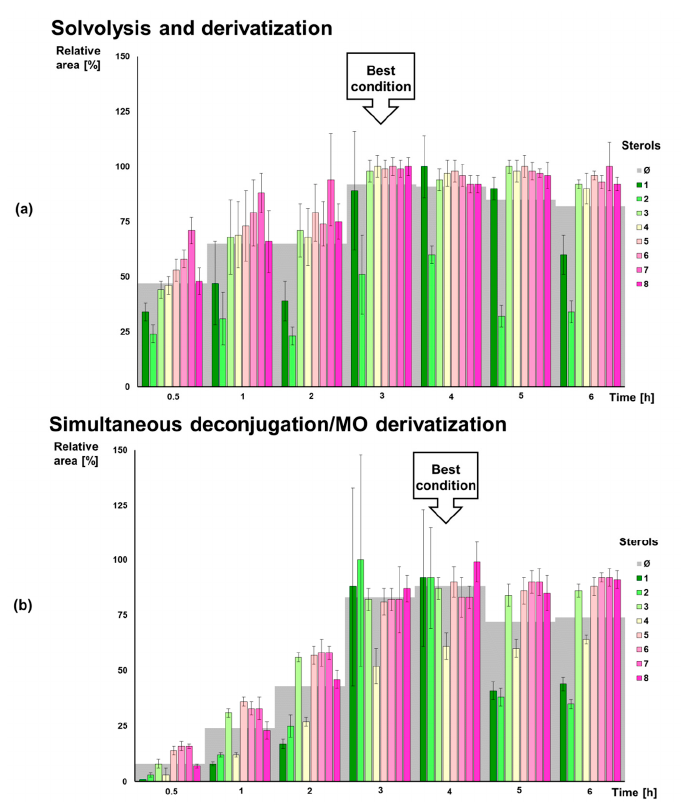
Figure 6. Determination of (keto-)sterol sulfates 1–8 as (MO-)TMS derivatives ( a ) with and ( b ) without previous sulfate solvolysis step (with 1% acetic acid in 1,4-dioxane). The indicated time refers to the duration of solvolysis prior to MO-TMS derivatization (for ”Solvolysis and derivatization”, ( a )) or to the incubation with O -methylhydroxylamine solution (for ”Simultaneous deconjugation / MO derivatization”, ( b )). The results obtained for each individual sterol sulfate under the di ff erent conditions are shown as relative peak areas [%] ± standard deviation (n = 6); the mean value of all steroids for every time point is shown in the background (grey), the best conditions for all tested sterol sulfates are marked as “Best condition”. The maximum recorded peak area for each sterol derivative within this experiment was set as 100%. Analyzed sterols: 1 androsterone sulfate, 2 dehydroepiandrosterone sulfate, 3 epiandrosterone sulfate, 4 allopregnanolone sulfate, 5 pregnanolone sulfate, 6 pregnenolone sulfate, 7 cholesterol sulfate, and 8 25-hydroxycholesterol